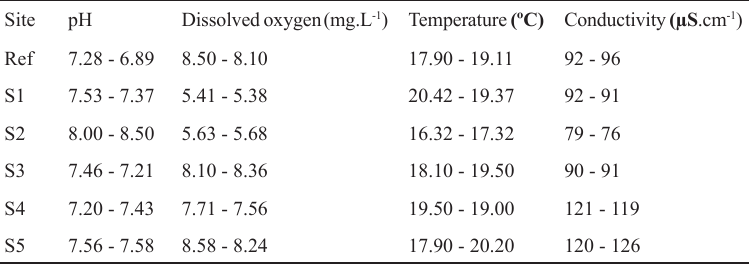
Table 1. Physical and chemical parameters of the water from the reference site (Ref) and from the sites along Água das Araras stream (S1, S2, S3, S4, and S5) collected in the first and last day of fish